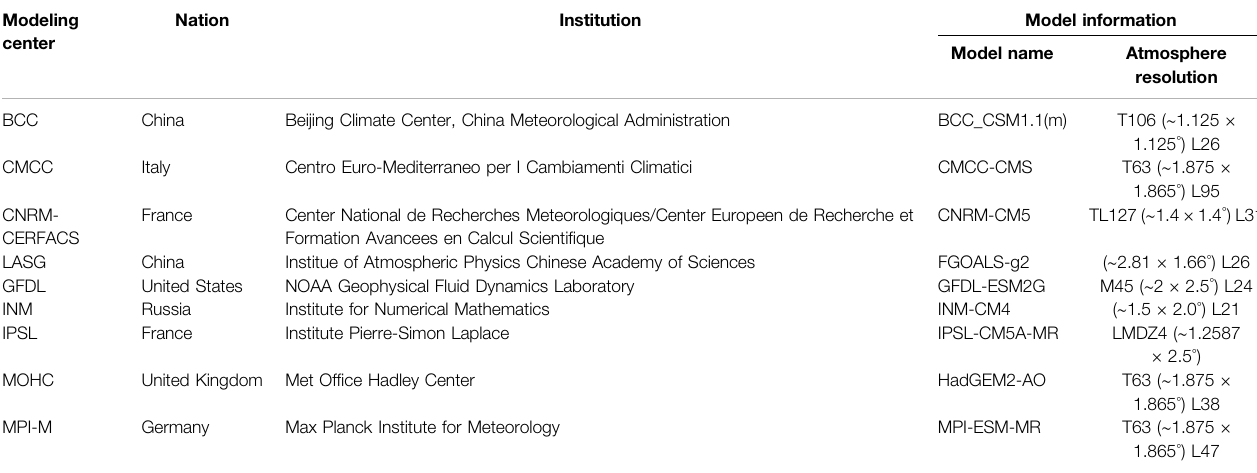
TABLE 1 | Details of the nine CMIP5 climate models.